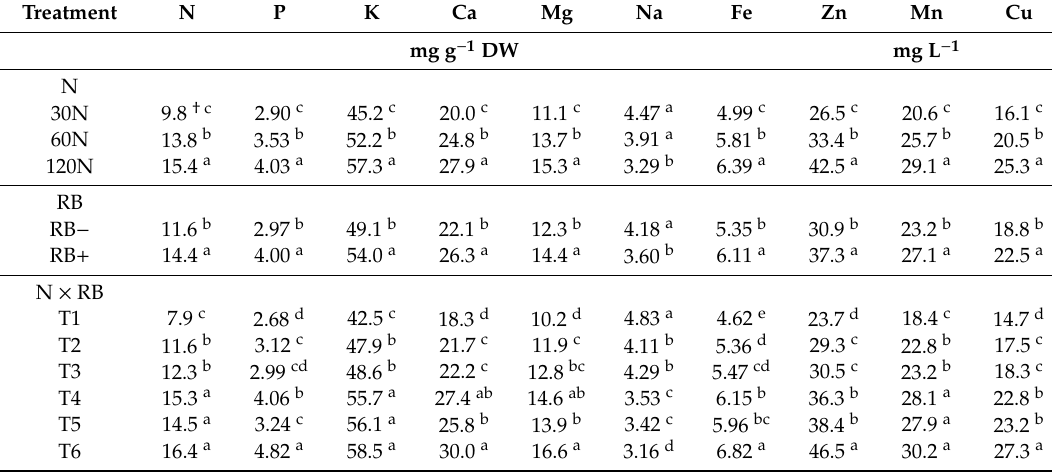
† Within each column and experimental factor, mean values with the same lowercase letter are not significantly di ff erent according to the Least Significant Di ff erence (LSD) test at p ≤ 0.05. Measurements were done 120 days after